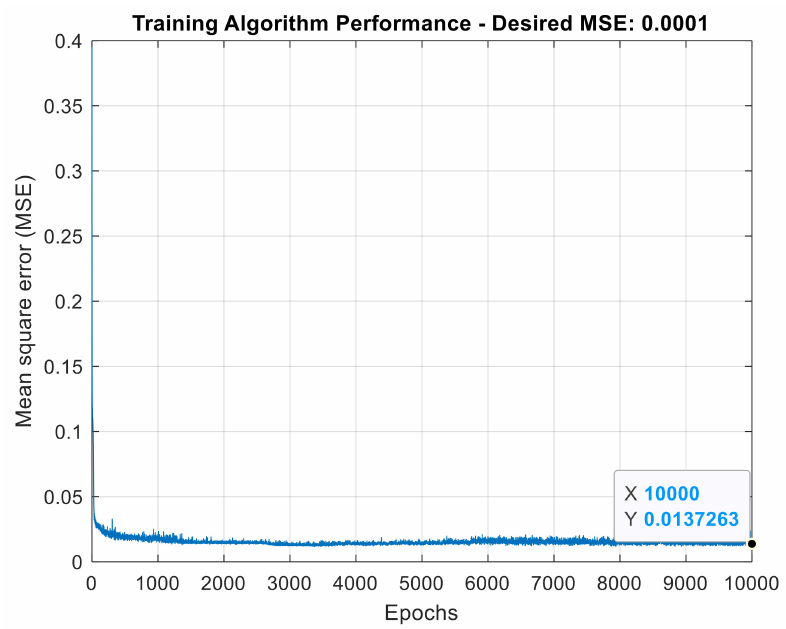
Figure 26. ANN training algorithm performance for wavelet AMR-based